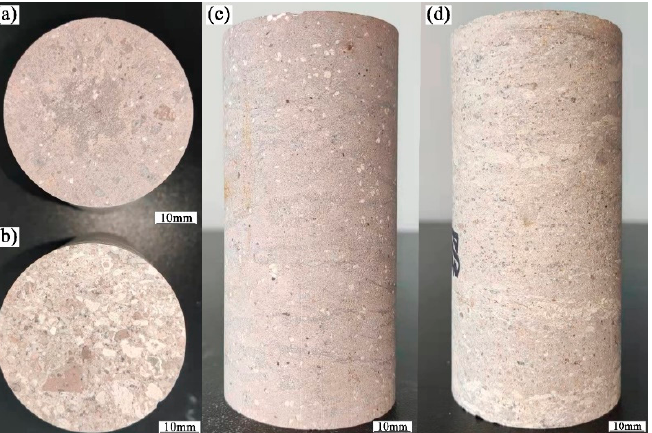
Figure 5. The tuff samples with various welding degrees were prepared for the mechanical tests: ( a , b ) the discs of strongly and weakly welded tuff for Brazilian splitting tests, respectively; ( c , d ) the standard cylindrical specimens of strongly and weakly welded tuff for uniaxial compression tests, respectively.